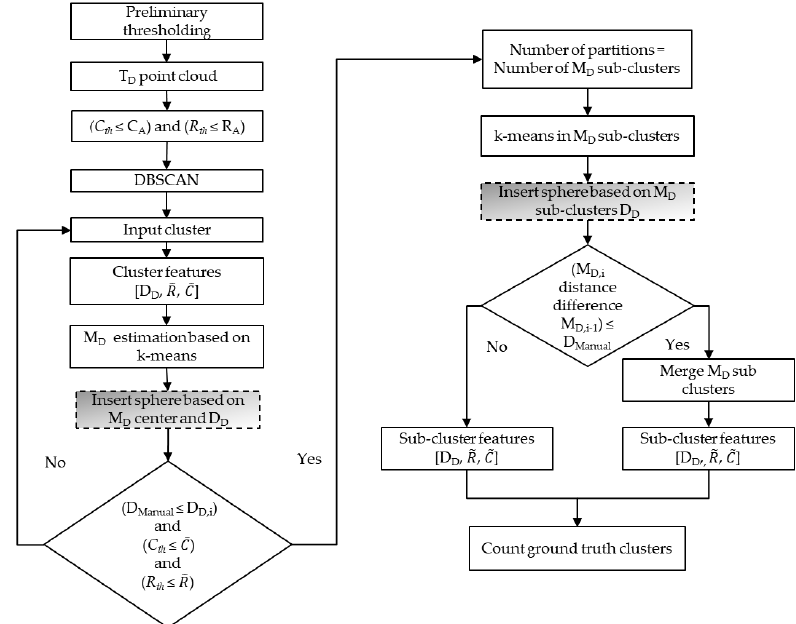
Figure 1. Flowchart showing the protocol for apple detection and sizing using defoliated trees (T D ), starting with the threshold application in the registered point cloud pair, through the filtering and partitioning, until the counting of clusters, which were compared to reference data from manual measurements and applied as ground truth when analysing the foliated trees. The cells with shading and dashed frame point out the differences from apple detection in foliated trees .